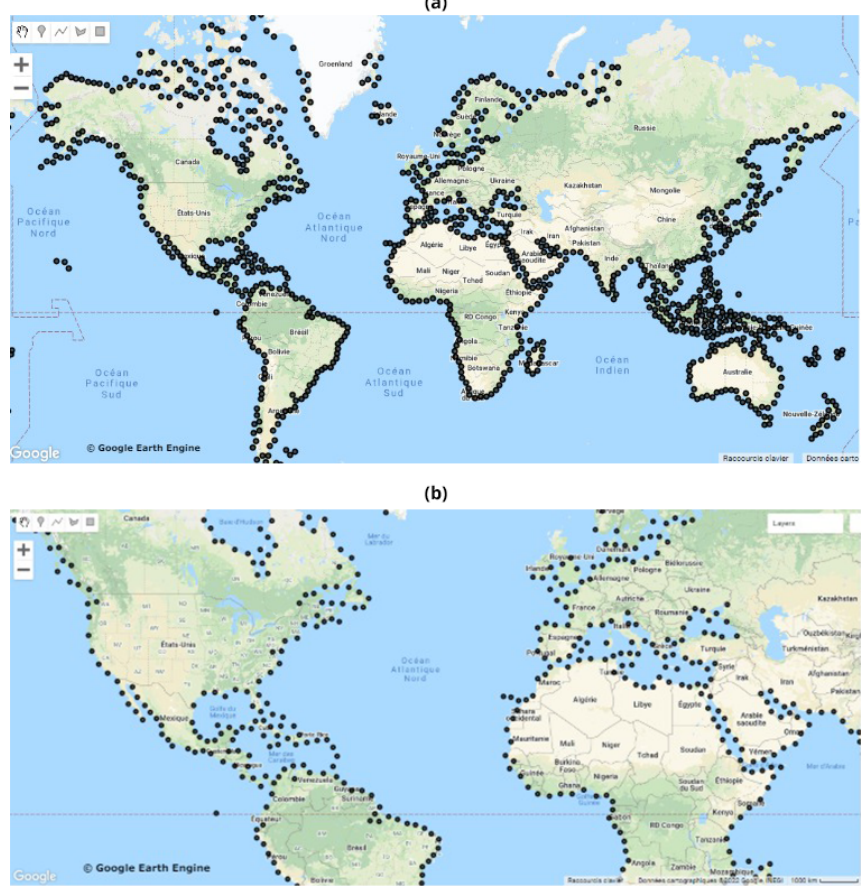
Figure 5. Distribution of the 1000 points selected by Algorithm 4 for the class “marine water bodies”: (a) global view and (b) zoomed-in